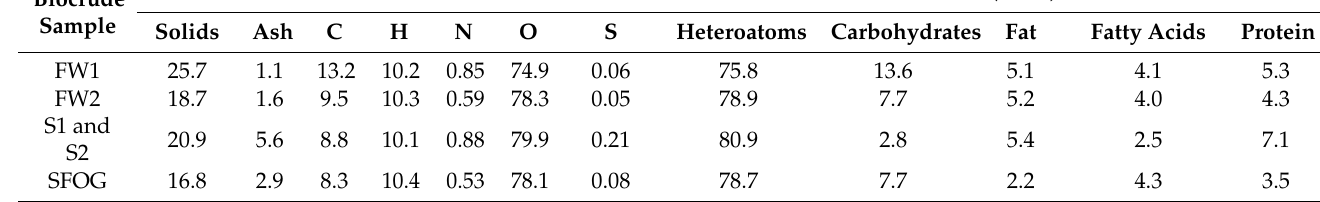
Table 2. Composition of the HTL feed materials processed in the preparation of the biocrude samples utilized in this